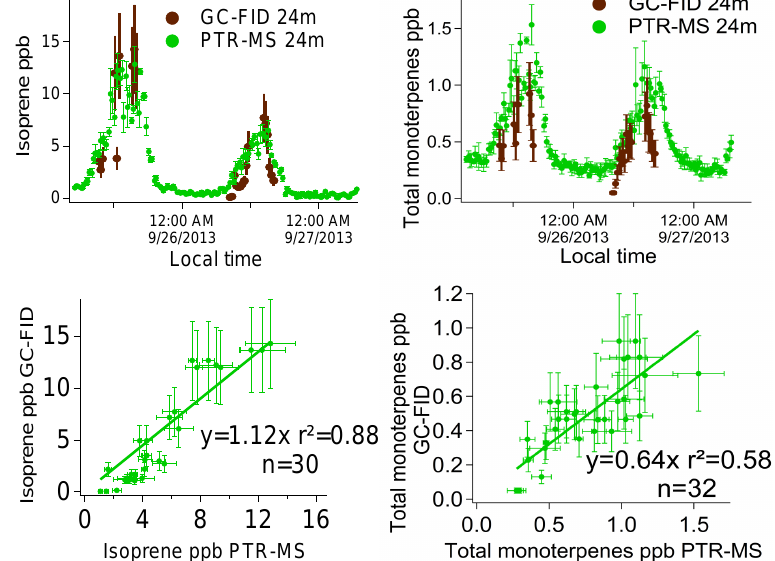
Figure 2. Top panels: example of PTR-MS and GC-FID time series data on 25 and 26 September 2013 at 24m for isoprene (left) and the total monoterpenes (right). Brown points are GC-FID measurements with an error of 30% and green points are PTR-MS continuous measurements with standard deviations of the 2min averages of the data. Bottom panel: correlation of isoprene (left) and total monoterpene (right) mixing ratios obtained by PTR-MS and